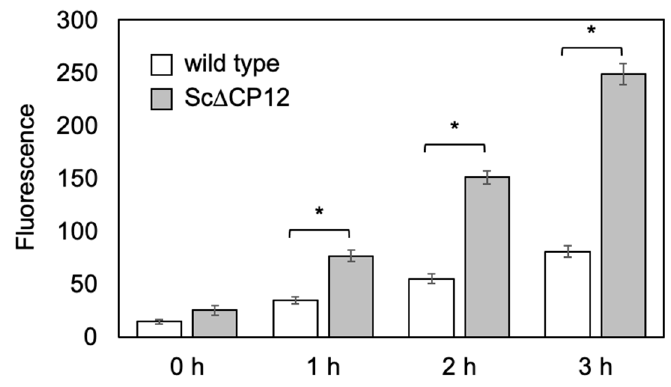
Figure 4. Intercellular ROS levels in wild-type and Sc ∆ CP12 mutant S. 7942 cells under high light conditions. Wild-type and Sc ∆ CP12 mutant S. 7942 cells were cultured in 1 L of Allen’s medium at 27 °C under continuous illumination (40 μ mol s − 1 m − 2 ) with bubbling of sterile air at 1 L min − 1 until the logarithmic growth phase, and then transferred to continuous illumination (200 μ mol s − 1 m − 2 ). Intercellular ROS levels were measured as described in the Materials and Methods. Values are the mean ± standard error of four individual experiments. Asterisks indicate significant differences from the wild-type cells (* p <